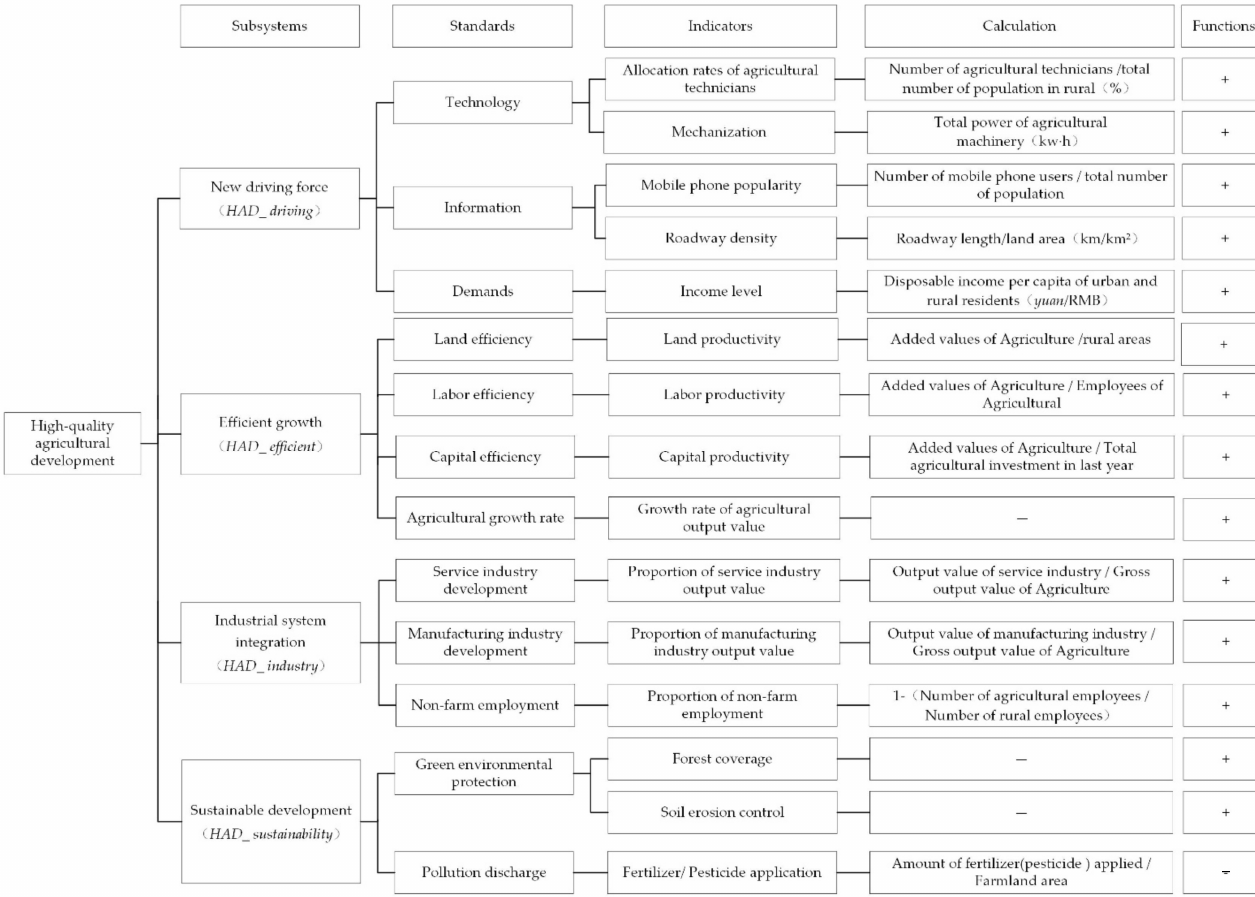
Figure 1. High-quality agricultural development measurement index